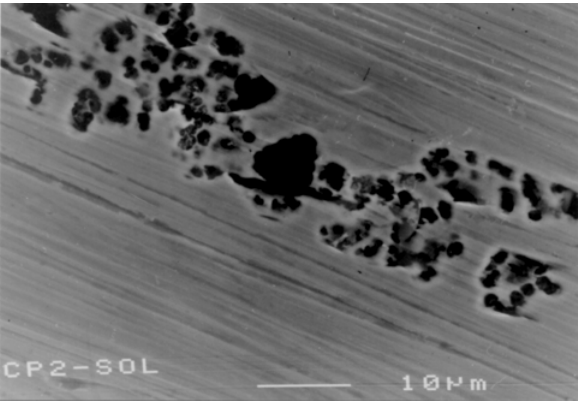
Figure 6. Localized corrosion on solution annealed 3RE60 alloy after the cyclic potentiodynamic polarization test. SEM - secondary electrons image. 3000X.